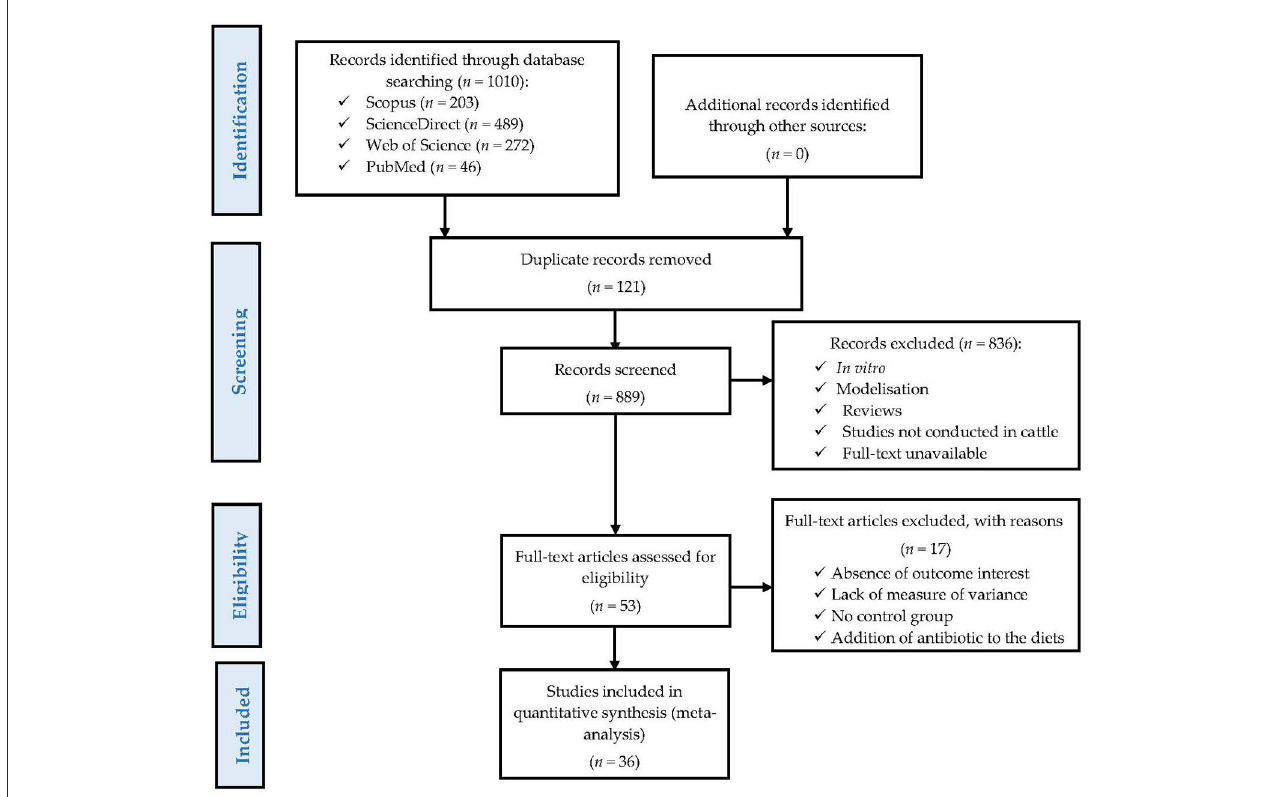
FIGURE1 A PRISMA flow diagram detailing the literature search strategy and study selection for the meta-analysis.